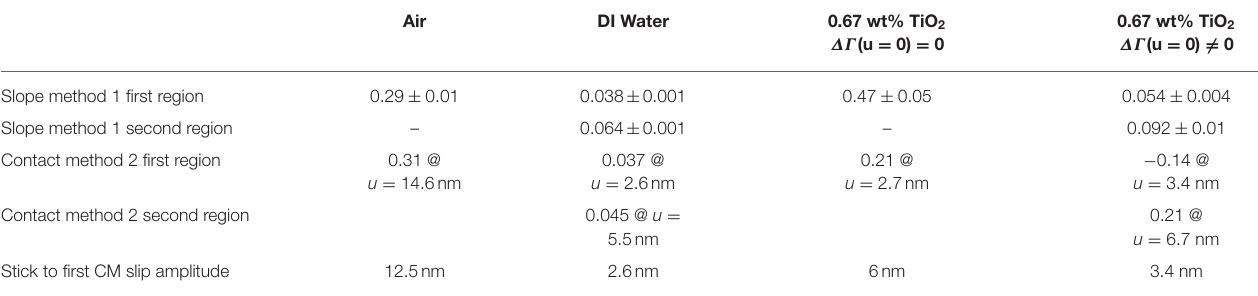
TABLE 1 | Friction coefficients inferred from the Figure 5 data by two analysis methods, along with the transition amplitude of vibration from stick to partial